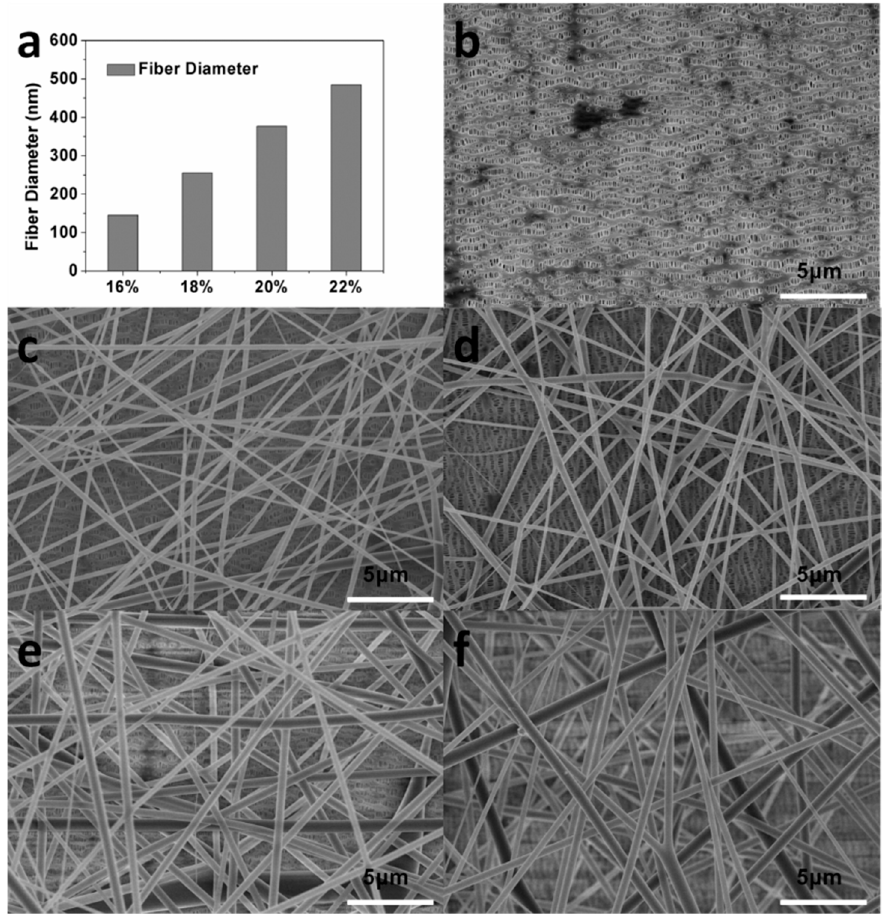
Figure 2. ( a ) The fiber diameter of polyethylene terephthalate (PET) nonwoven membrane top layer with different concentrations of PET; SEM image of the polypropylene (PP) separator ( b ) and composite separators ( c – f ): PET/PP-16%, PET/PP-18%, PET/PP-20%, PET/PP-22%.